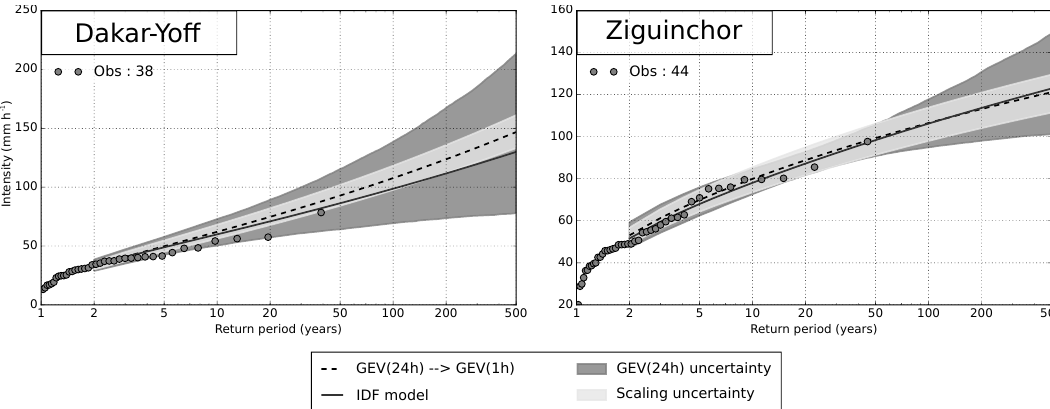
Figure 8. Return level plot for the 1h duration – GEV(1h) – at two emblematic stations over Senegal: Dakar and Ziguinchor. The estimates come from the GEV estimates at the 24h duration – GEV(24h) – downscaled to the 1h duration (dashed line). Shaded areas represent the 90% confidence interval of uncertainty due to the fitting of GEV(24h) and of uncertainty due to the downscaling. Obtained GEV(1h) from the fitted IDF SiSca at these stations are also displayed (solid line). The circles represent the observed annual maxima intensities i(D) .